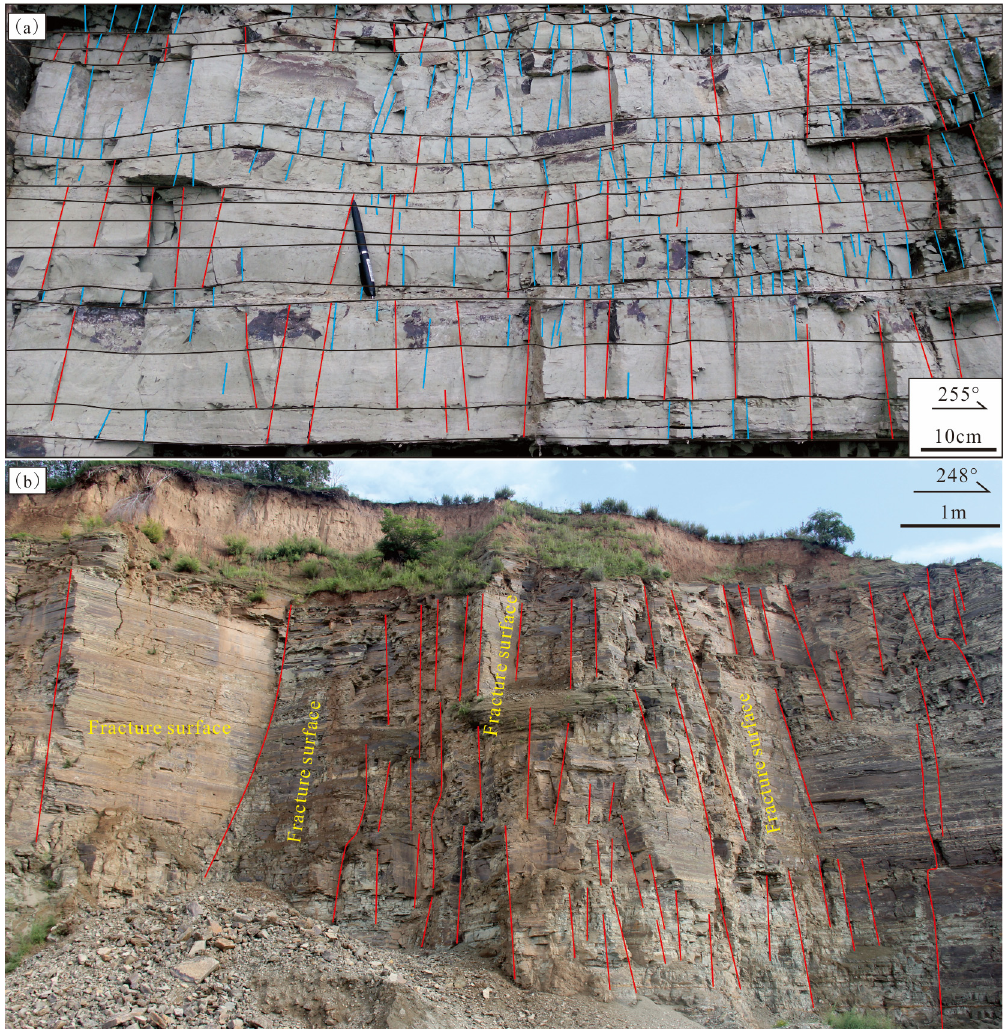
Figure 2. ( a ) Strata-confined fractures (blue lines) and throughgoing fractures (red lines); ( b ) through- going fractures (red